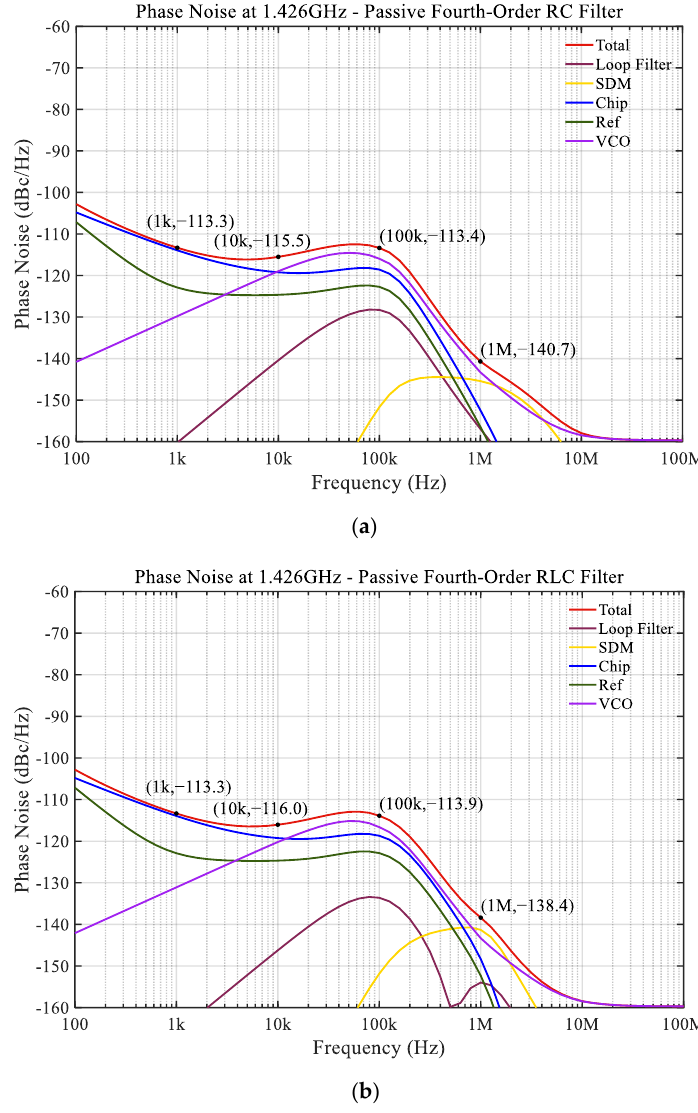
Figure 7. Phase noise simulation results: ( a ) passive fourth-order RC filter and ( b ) passive fourth- order RLC filter.